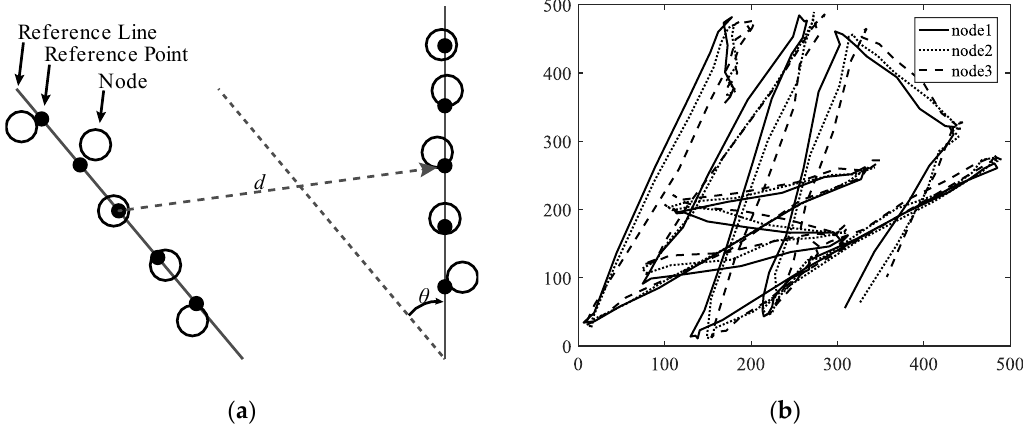
Figure 4. Path-Planned mobility trajectories: ( a ) Semi-Random circular mobility model; ( b ) Paparazzi autopilot UAV Movements ( Stay-At , Eight , Way-Point , Scan , and Oval ); and ( c ) PPRZM state machine. Figure 6. Column mobility models: ( a ) Example of a single step in CLMN where each node has its reference point and reference points are placed on a reference line that moves a distance d and rotates an angle θ ; ( b ) Trajectory simulation of three nodes using CLMN where reference points randomly move through the simulation area and each node moves randomly around its reference point.